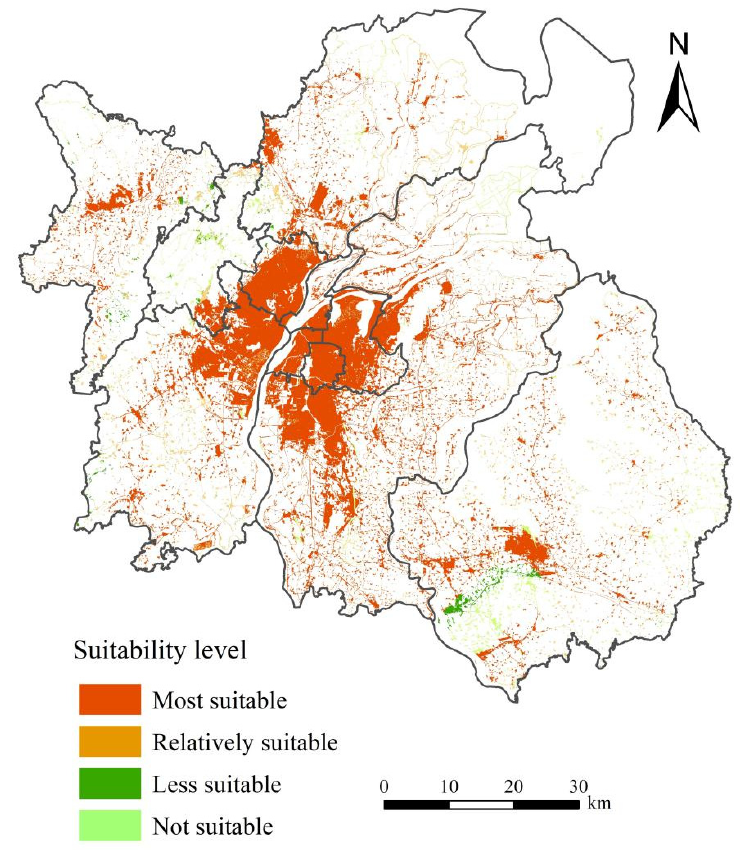
Figure 5. Spatial distribution of the suitability of current urban–rural construction land in the study region.